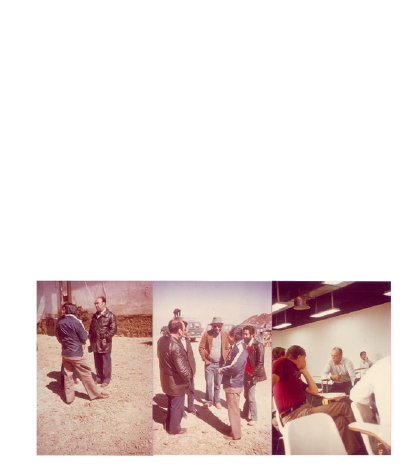
Figure 9. Request to C4 / IUPAP1.